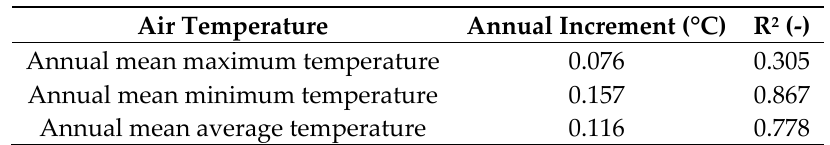
Figure 2. ( a ) Annual mean maximum air temperatures recorded in the study area from 2004 to 2016 (black dots) with linear fit and the corresponding 95% confidence intervals plotted; ( b ) Annual mean minimum air temperatures recorded in the study area from 2004 to 2016 (black dots) with linear fit and the corresponding 95% confidence intervals plotted. Table 1. Annual increments of mean maximum, minimum and average air temperatures, with their relative R 2